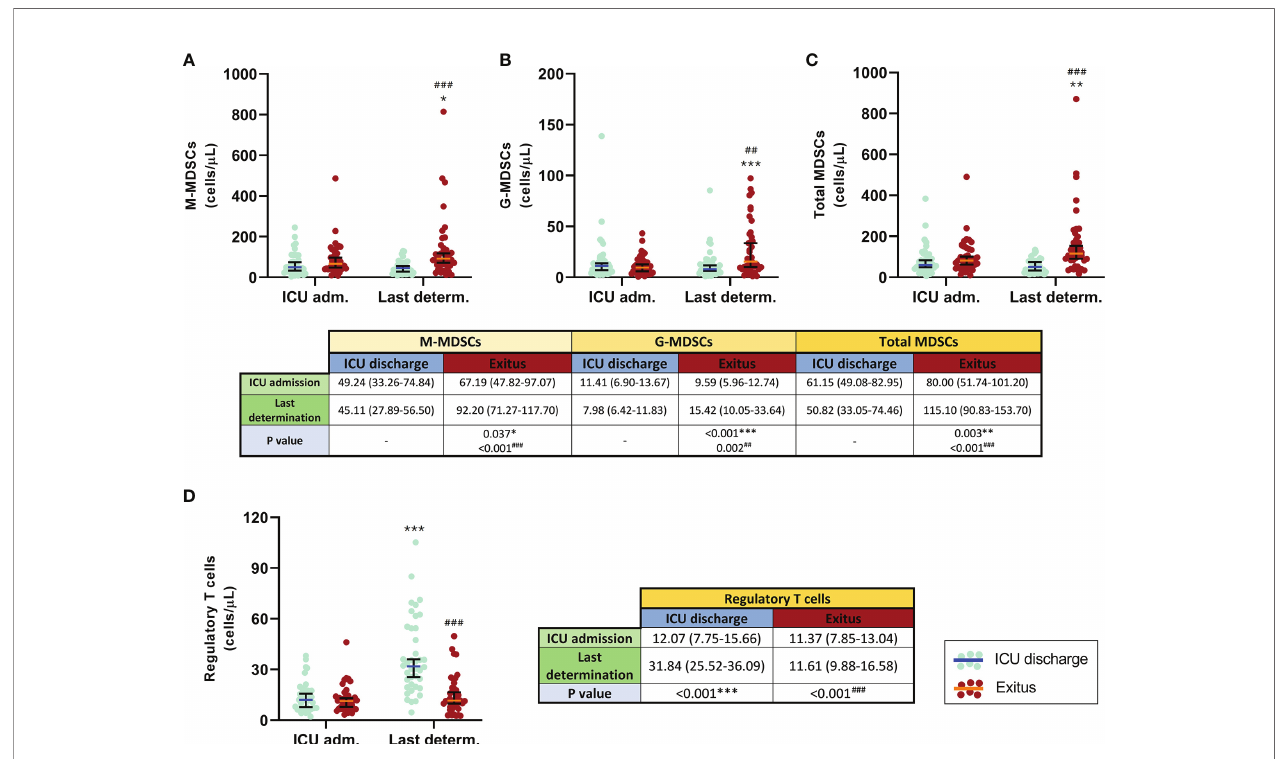
FIGURE 2 | Comparison of circulating myeloid-derived suppressive cells (MDSCs) and regulatory T cells (Tregs) in discharged ( blue ) and deceased ( red ) coronavirus disease 2019 (COVID-19) patients between the fi rst and the last determination in the ICU. (A) Monocytic MDSCs. (B) Granulocytic MDSCs. (C) Total MDSCs. (D) Tregs. All data shown are the median and 95% con fi dence intervals of cells per microliter. ## p ≤ 0.01, ### p ≤ 0.001 comparing opposite groups, respectively; * p ≤ 0.05, ** p ≤ 0.01, *** p ≤ 0.001 compared with ICU admission,